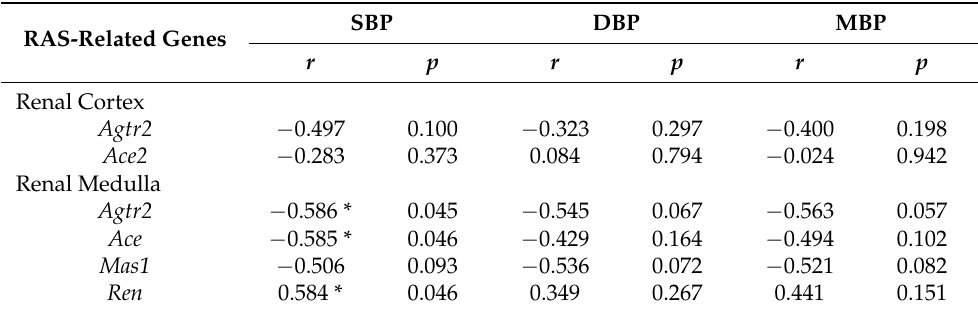
Table 6. Pearson correlation analysis between RAS-related genes modulated by EGCG supplementa- tion and blood pressure